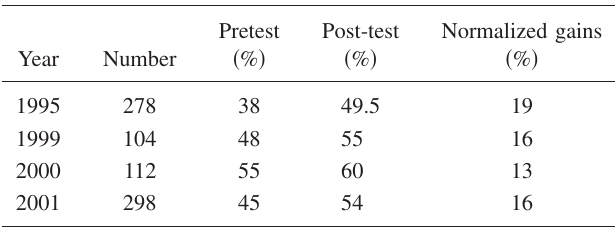
TABLE II. Post-test gains for traditional teaching in 1995, and from 1999 to 2001.